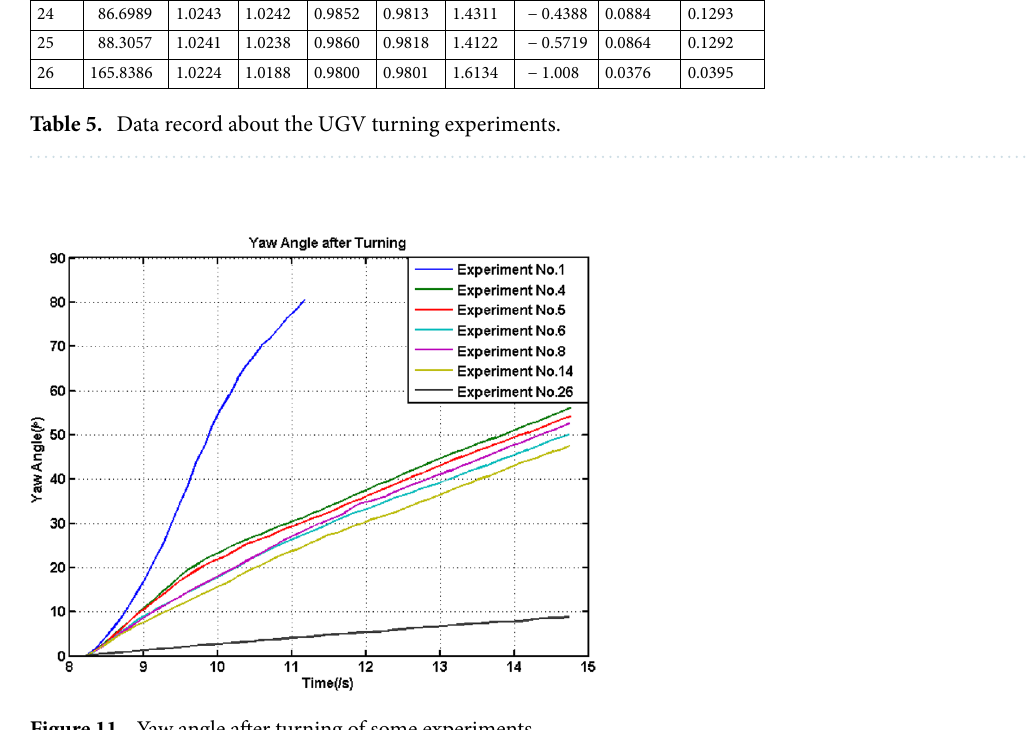
Figure 11. Yaw angle after turning of some